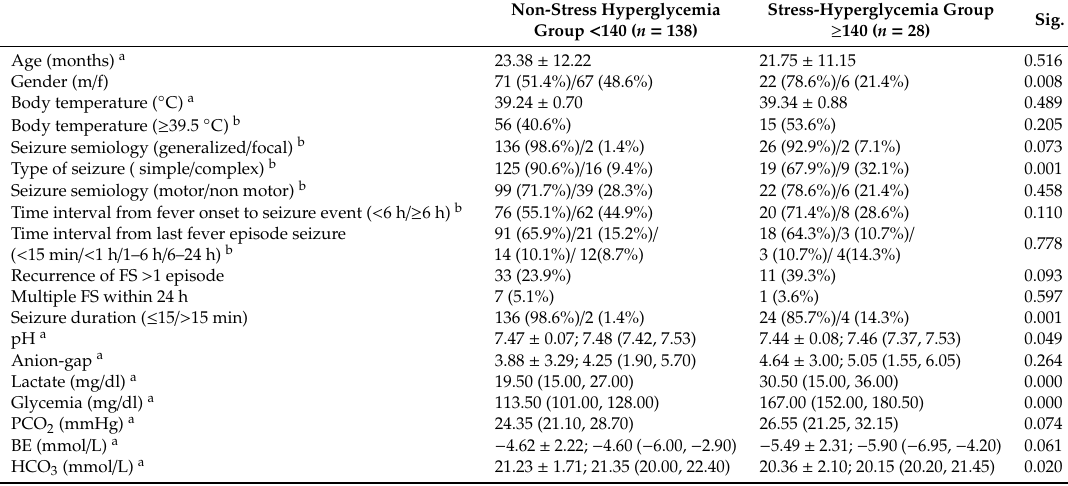
Table 1. Comparison of characteristics for children with stress hyperglycemia versus non-stress hyperglycemia